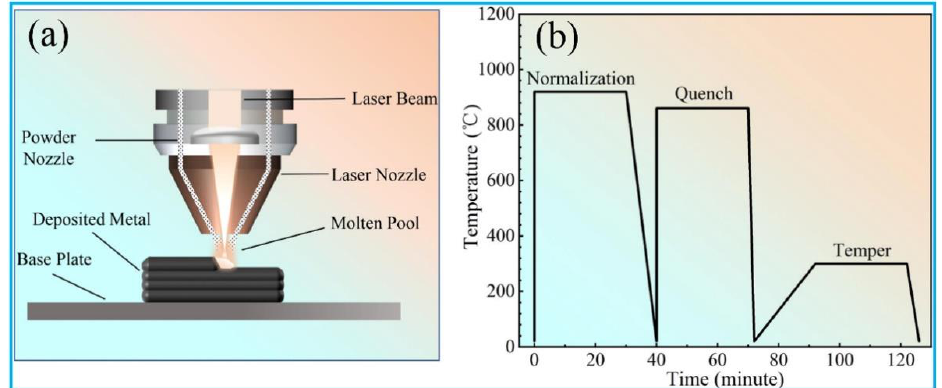
Figure 1. ( a ) Schematic diagram of the LMD machine. ( b ) Illustration of the heat treatment process. The optimal experimental parameter was selected. The experimental process param- eters were a laser power of 2000 W, a scanning speed of 10 mm/s, an overlap ratio of 50%, and a laser scan strategy with layers alternating by 90° in the x – y plane. Three samples with different batches of powders were printed using these parameters. The powder mor- phology of ultrahigh strength martensitic steel is approximately spherical, and its size is 50 –150 μm, as shown in Figure 2. Before printing, the powder was dried in a vacuum oven (Shanghai Yiheng Technology Co., Ltd., Shanghai, China) for 2 h at 200 °C. The chemical compositions with different batches of powders are presented in Table 1. It has been clearly seen that the chemical compositions of powders change slightly in different batches, which may influence the microstructures and mechanical properties of as-printed samples. Low-carbon steel was selected as the base plate, which was annealed, polished, and cleaned, and then all samples were printed on this substrate.